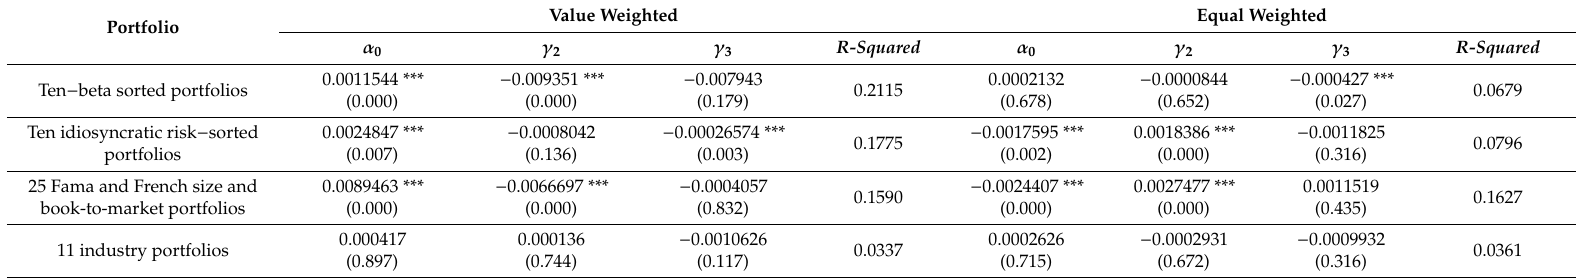
Table 3. Estimation results of Equation (6).